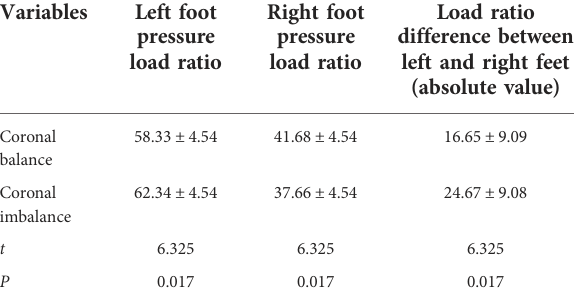
TABLE 6 Difference in right and left foot pressure load ratio between the coronal balance and imbalance group (mean±standard deviation).